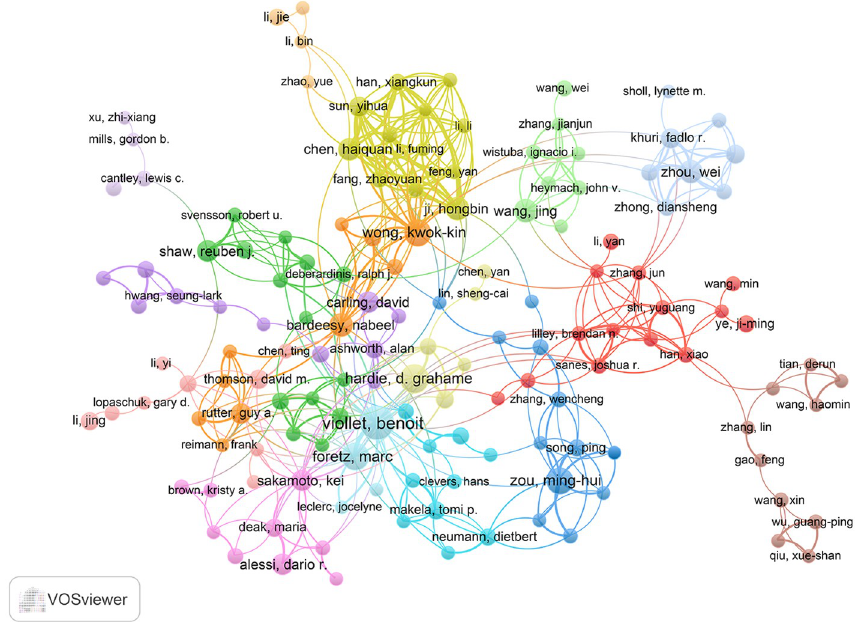
Fig 5. Co-authorship network of authors producing LKB1